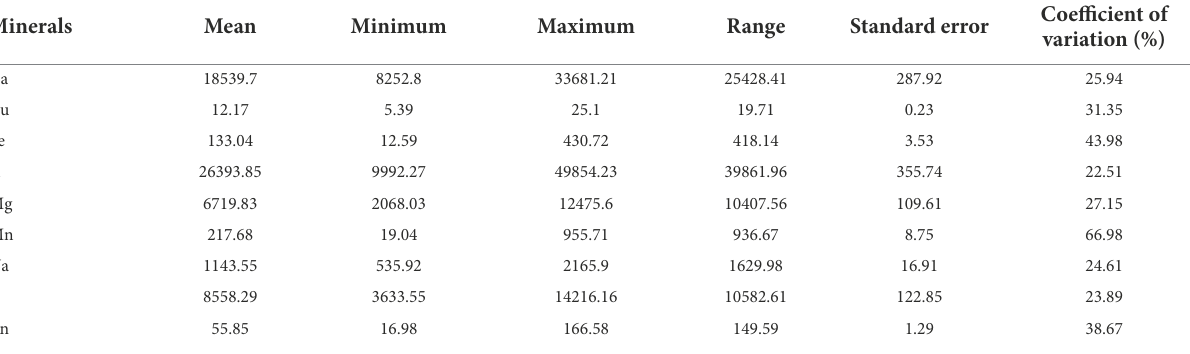
TABLE 2 Descriptive statistics of nine mineral contents in a population of 70 advanced lines of G. gynandra evaluated across years (2020 and